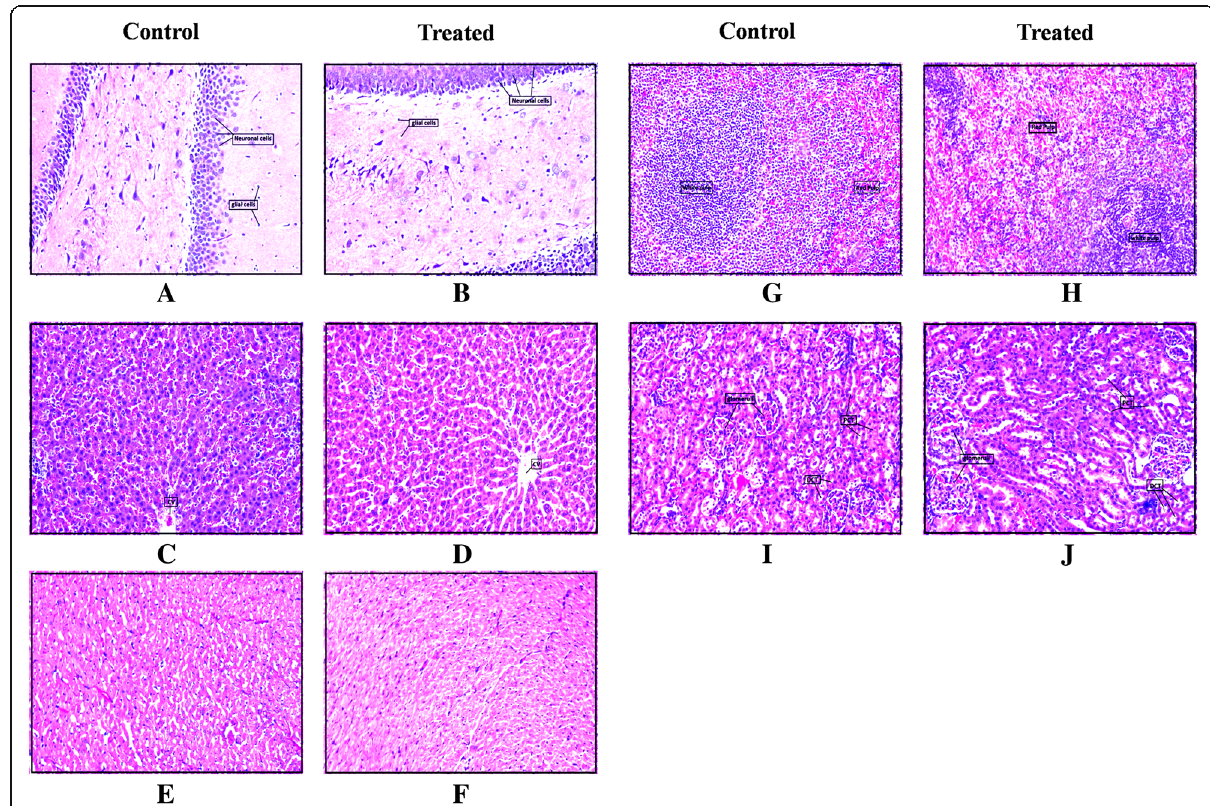
Fig. 6 Effect of 1000 mg kg − 1 of Asdamarin on histology of vital organs of female rats. a and ( b ): brain; ( c ) and ( d ): liver; ( e ) and ( f ): heart; ( g ) and ( h ): spleen; ( i ) and ( j ): kidney. cv, central vein; DCT, distal convoluted tubule; PCT, proximal convoluted